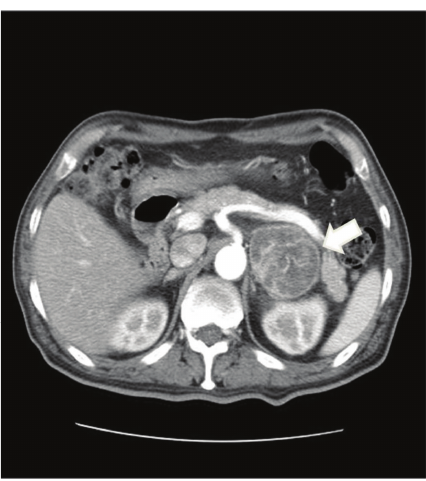
Figure 1: Contrast-enhanced abdominal computed tomography shows a heterogeneously enhancing left adrenal mass (4.8 × 5.7 cm) with irregular internal tumor necrosis (white arrow). There was no abnormality in the right adrenal gland (not